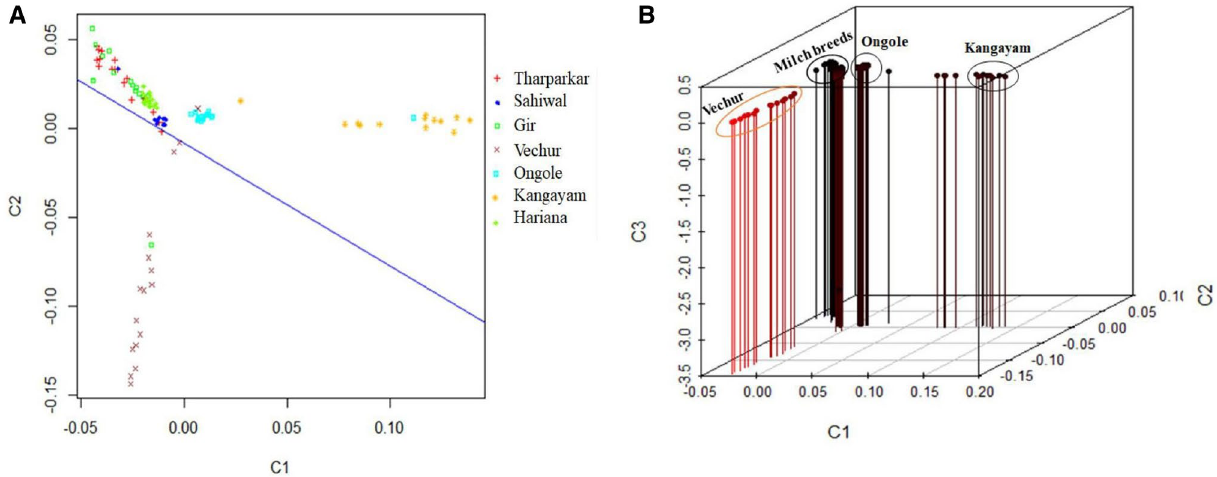
Figure 4. Multi-dimensional scaling plots of genome-wide IBS pairwise distances. A: 2D plot, wherein blue line represents the rotated X-axis (PC1 space) and explains maximum variability of the data; B: 3D plot.